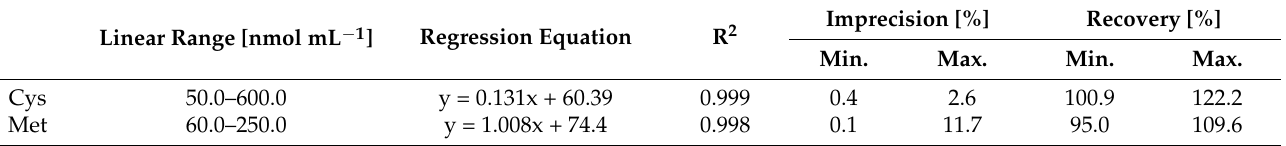
Table 1. Validation